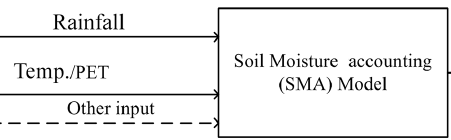
Figure 2. The modelling framework in the HYDROMAD package.